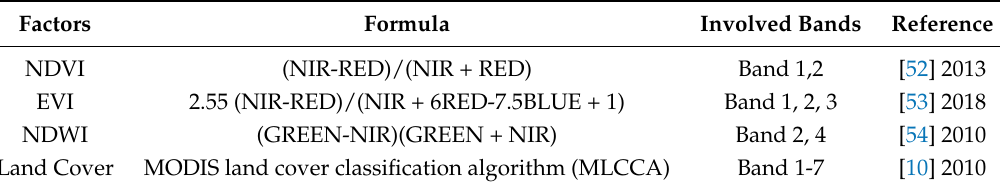
Table 2. The selected environmental factors and corresponding MODIS land reflectance bands used in this application. We also list the relevant waterfowl study which used the same factor. RED represents the wavelength of 620–670 nm for MODIS Land Bands; NIR covers the wavelength of 841–876